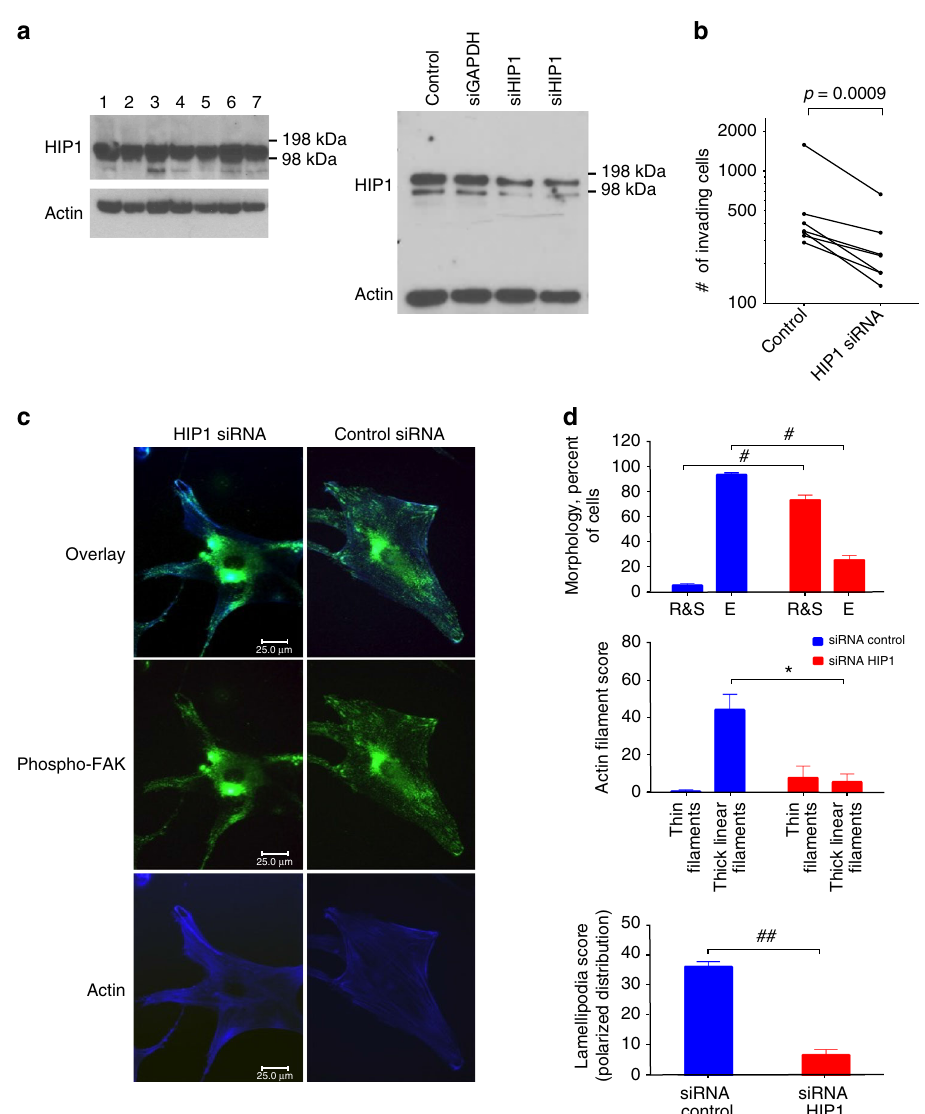
Fig. 5 Biologic validation of HIP1 as a key pathway in RA FLS. a Left: HIP1 protein expression in FLS; right: decreased HIP1 expression induced by siRNA knockdown. b HIP1 de fi ciency signi fi cantly reduced RA FLS invasion through Matrigel. c HIP1 and cytoskeletal rearrangement. Left three panels: morphologic differences in HIP1 de fi cient cells demonstrate a stellar morphology with reduced number and size of lamellipodia and reduced co-localization of phospho-FAK. Right three panels: RA FLS transfected with siRNA control (green = phospho-FAK; blue = phalloidin/actin fi laments; ×600 magni fi cation). d Altered phenotype of the HIP1-de fi cient FLS. Top panel: siRNA HIP1 had reduced cell elongation (E elongated; R&S round and stellar morphology; # p -value = 0.0006). Middle panel: siRNA HIP1 decreased thin central fi laments and thick actin fi laments. * p -value = 0.003). Bottom panel: siRNA HIP1 knockdown also reduced the number of lamellipodia and their polarized distribution. (## p -value = 0.0008). All p -values are calculated by paired t -test, and error bars indicate standard